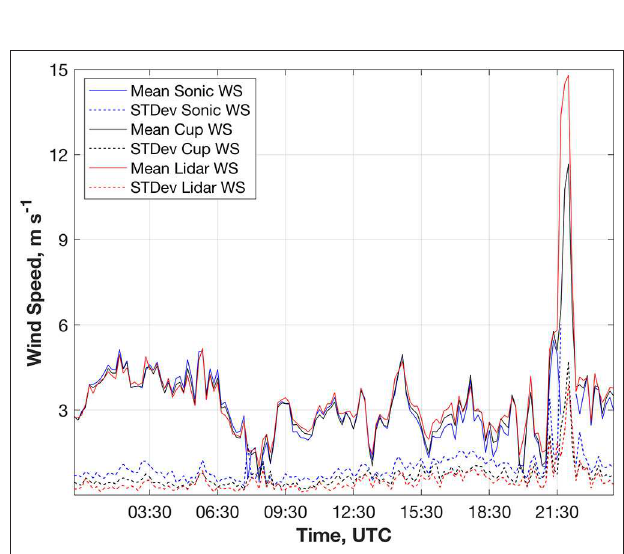
FIGURE 5 | Comparison of the 10min averaged horizontal wind speeds and 10min standard deviations of the horizontal wind speeds of the different measurement platforms at the One Energy calibration complex on 3 July